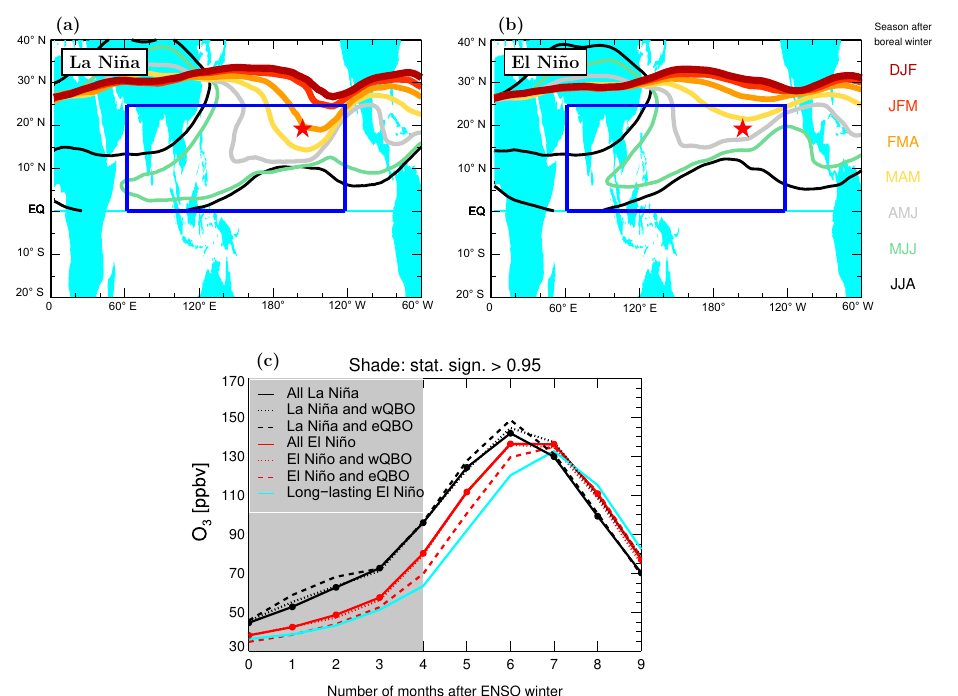
Figure 10. (a, b) Same as Fig. 8 but for CLaMS ozone with the isoline value of 120ppbv. (c) Same as Fig. 8c but also including the results for ENSO subcomposites with the QBO westerly phase (dotted line), QBO easterly phase (dashed line) and long-lasting El Niño events (cyan line).